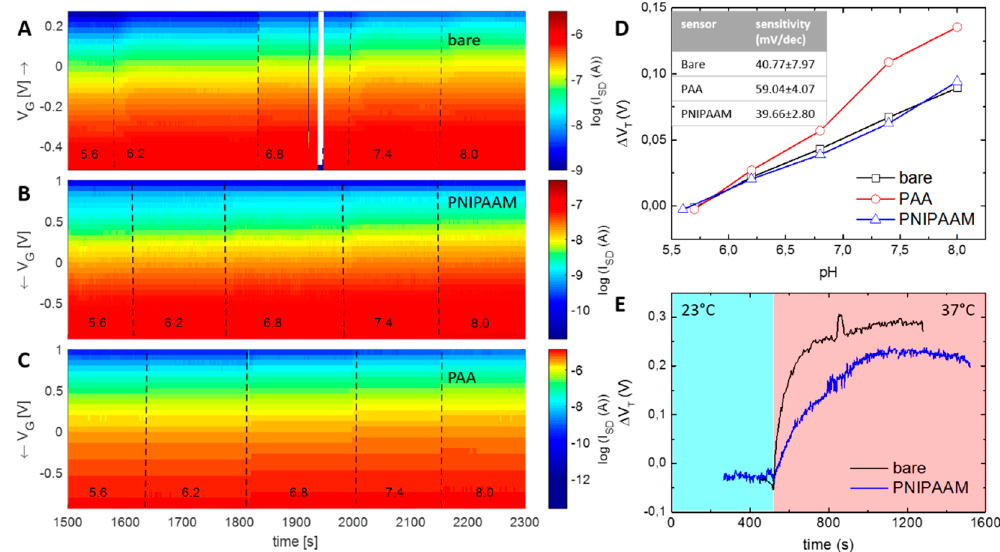
Figure 4. ( A ) Real-time response of the unmodified sensor upon exposure to different pH. ( B ) Real-time response of PNIPAAM-modified SiNW FET upon exposure to different pH. ( C ) Real-time response of the PAA-modified sensor upon exposure to different pH. Source–drain currents are